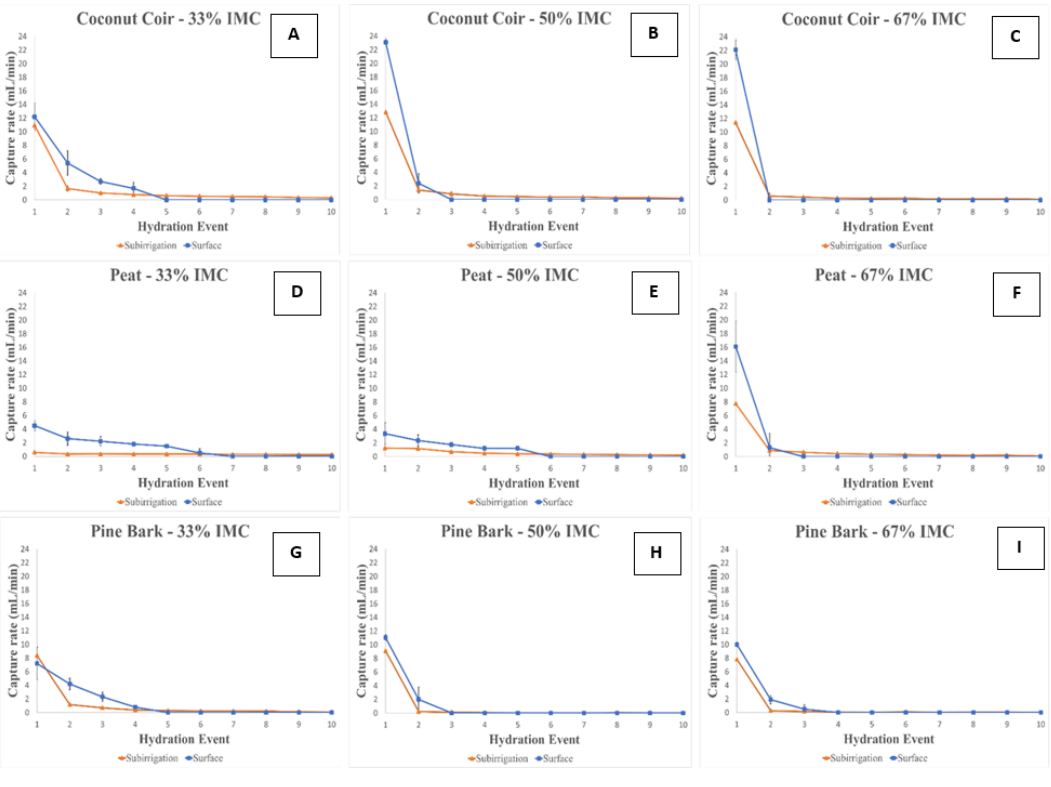
Figure 5. Water capture rate (CR) for peat, coir, and pine bark over ten irrigation events at three moisture contents and two irrigation techniques. With ( A ) coir at 33% IMC, ( B ) coir at 50% IMC, ( C ) coir at 67% IMC, ( D ) representing peat at 33% IMC, ( E ) peat at 50% IMC, ( F ) peat at 67% IMC, ( G ) pine bark at 33% IMC, ( H ) pine bark at 50% IMC, and ( I ) pine bark at 67% IMC.